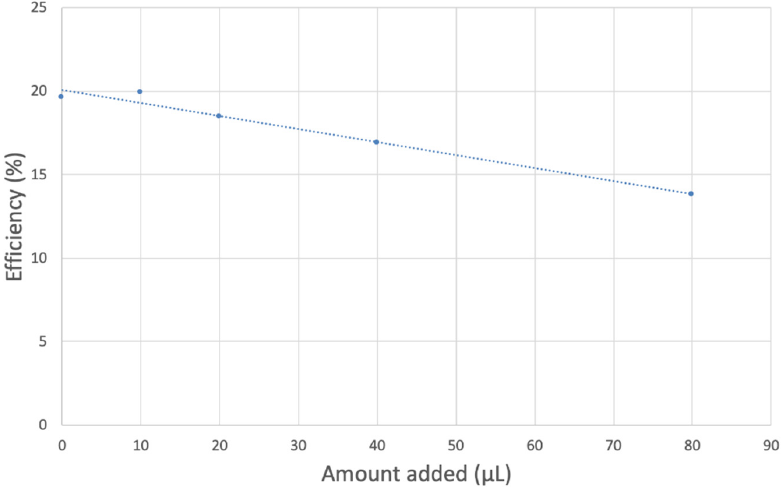
Figure 17. Black seed oil collection efficiency of blank plus first four aliquots, y = − 0.0781x + 20.08,